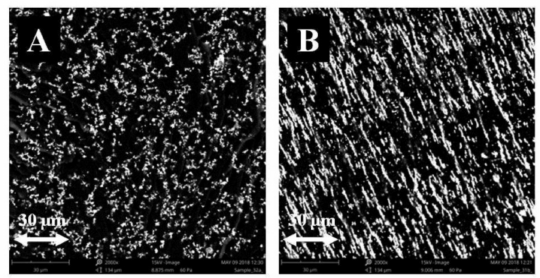
Figure 5. Microstructure of epoxy resin composite (Ep 5) and Fe 3 O 4 polymerized without CMF ( A ) and in CMF of magnetic induction B = 0.5 T ( B ), magnification 2000 ×